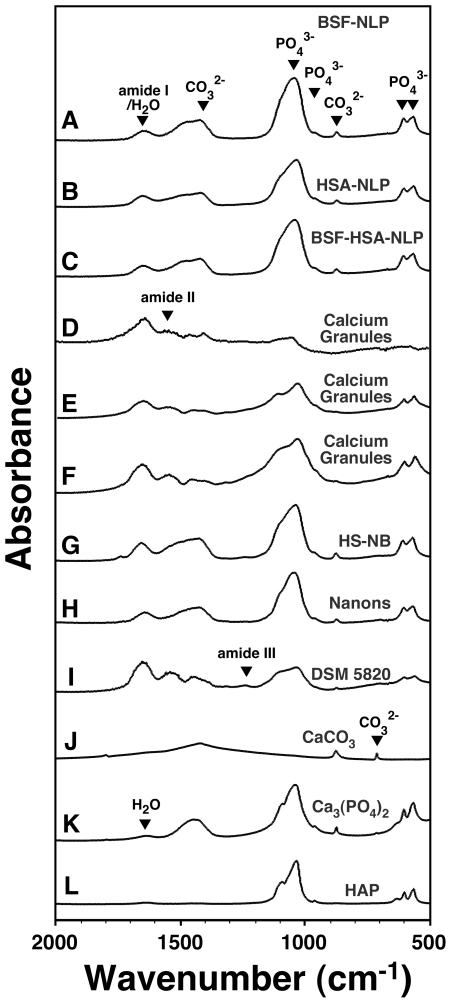
Fourier-transformed infrared spectroscopy of protein-mineral nanoparticles reveals the presence of both carbonate and phosphate.Protein-mineral nanoparticles were obtained as described in Fig. 9, by diluting BSF (A), HSA (B), or both proteins (C) into DMEM, then adding 0.3 mM each of CaCl2 and NaH2PO4, and incubating the solutions in cell culture conditions for 1 month. Calcium granules were prepared by adding either CaCl2 (D) or NaH2PO4 (E) into FBS, or a combination of both CaCl2 and NaH2PO4 (F) into HS, as described in the
Materials and Methods
. NB were cultured from 10% HS (G, “HS-NB”) or 10% FBS (H and I, corresponding to “Nanons” and “DSM 5820”, respectively). The FTIR spectra of the protein-mineral nanoparticles revealed peaks similar to both calcium granules and NB as shown by the presence of phosphate peaks at 575 cm−1, 605 cm−1, 960 cm−1, and 1,000–1,150 cm−1 as well as carbonate peaks at 875 cm−1 and 1,400–1,430 cm−1. Some of the peaks corresponding to phosphate or carbonate were not detected in a few calcium granule samples such as the one shown in (D). In the various nanoparticle samples presented here, peaks corresponding to amide I, II, and III at 1,660 cm−1, 1,550 cm−1, and 1,250 cm−1, respectively, were observed and were attributed to the presence of serum proteins. Spectra for the controls CaCO3 (J), Ca3(PO4)2 (K), and HAP (L), diluted and washed in double-distilled water, were included as controls. Residual water (H2O) was observed at 1,650 cm−1 in some controls prepared in the absence of proteins (K and L); this peak could also have contributed to the intensity of the amide I peak seen at 1,660 cm−1 in the other samples shown.